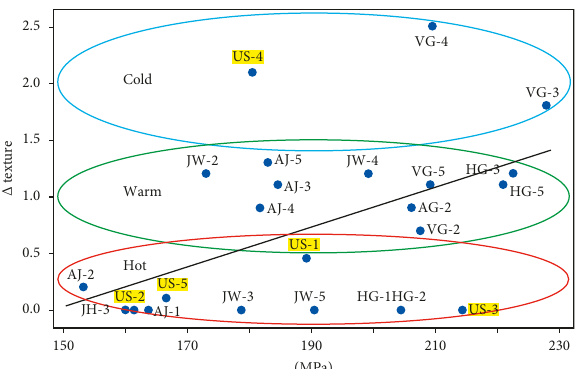
Figure 11: Dependence of the Δ texture (maximum-minimum in the texture coefficient) on the estimated prestrike hardness of each alloy is indicated by the regression line ( r 2 � 0.29, n � 20, P � 0 . 014; unstruck flans not included). Regions of hot, warm, and cold strikes based solely on the Δ texture are indicated with ovals that are meant to focus attention and do not indicate statistical